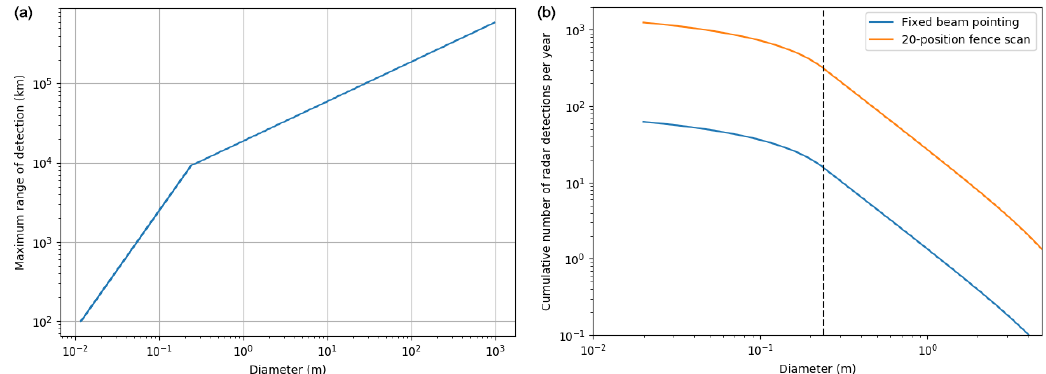
Figure 5. (a) Maximum range at which an object of a certain diameter is detectable with E3D with a 0.2s coherent integration length. The range grows initially faster due to object sizes being in the Rayleigh scattering regime, where the radar cross section grows proportionally to σ ∝ D 6 , and where D is object diameter. Once the transition to geometric scattering occurs, the maximum detectable range grows more slowly. (b) The estimated cumulative number of radar detections per year with E3D, assuming 100% time use. The blue line is without beam scanning, and the orange line is with a 20-position fence scan. The black broken line indicates the transition from Rayleigh to geometric